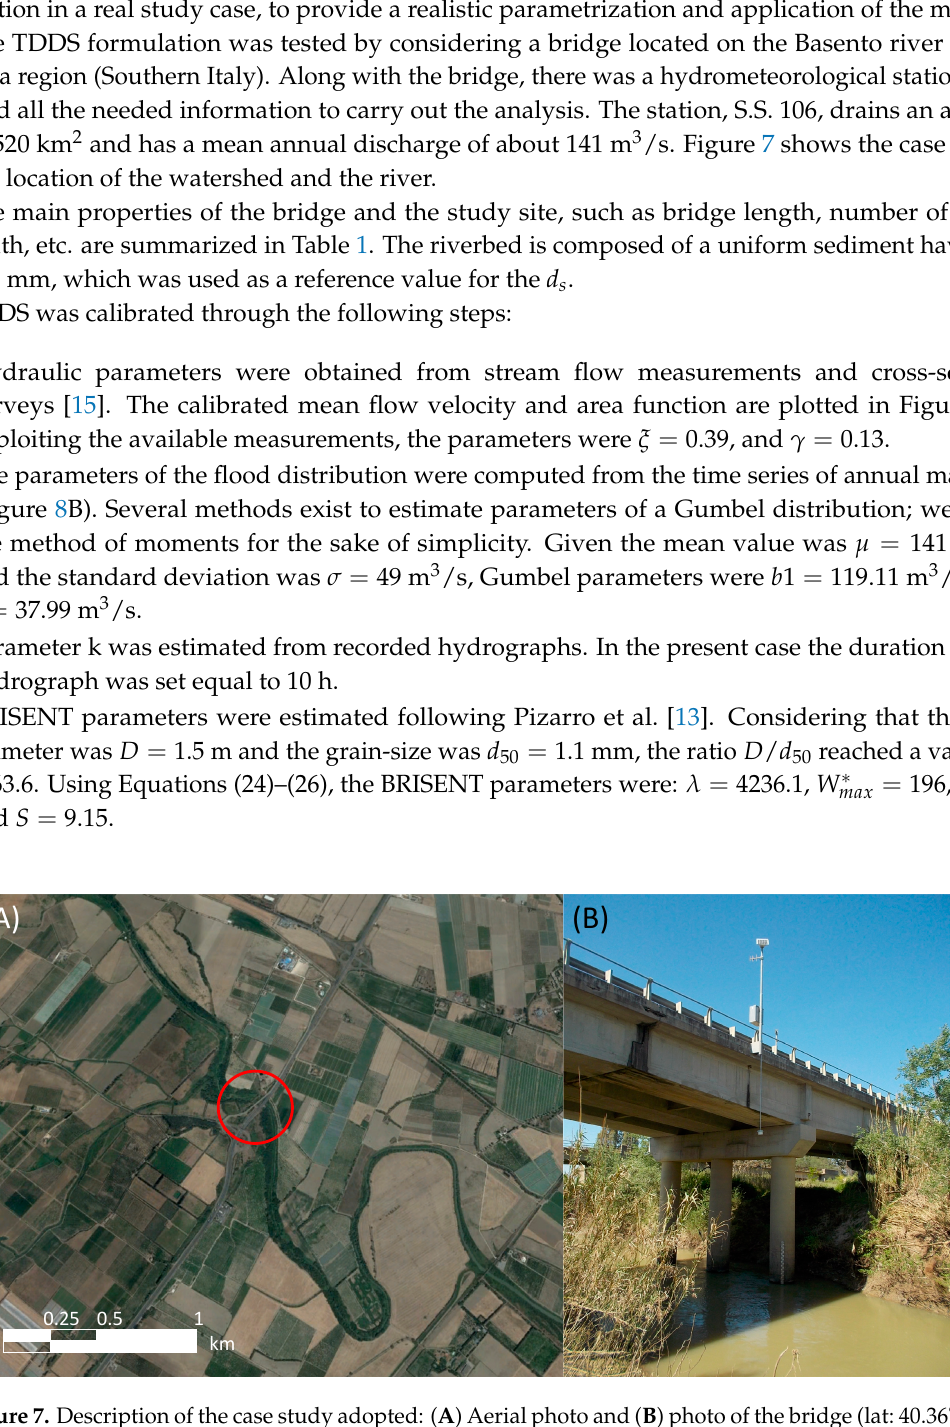
Figure 7. Description of the case study adopted: ( A ) Aerial photo and ( B ) photo of the bridge (lat: 40.36°; lon: 16.78°). Table 1. Main characteristics of the selected study case.